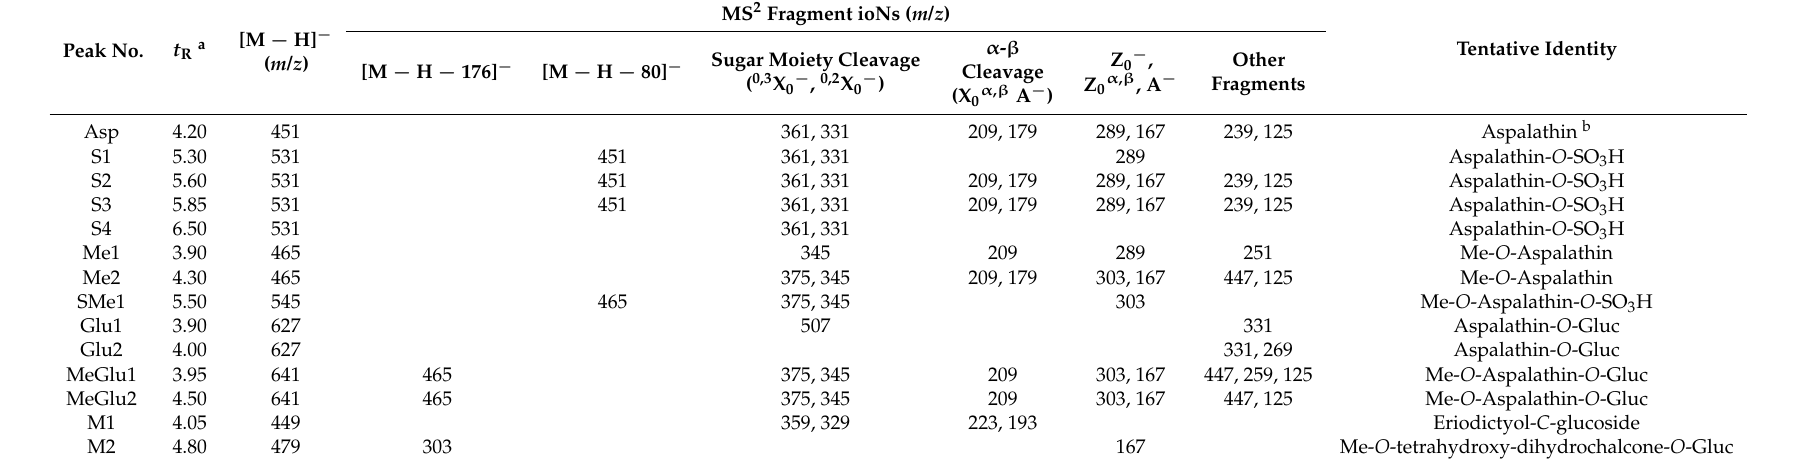
Table 5. Tentative identification of aspalathin metabolites in mouse urine after an oral dosage of 50 mg/kg.